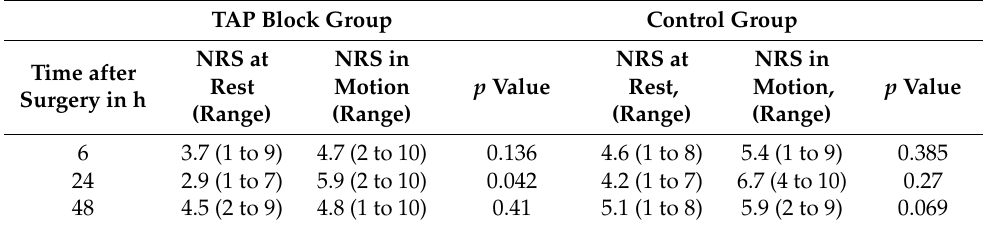
Table 1. Postoperative pain assessment with Numeric Rating Scale (NRS). TAP Block Group Control Group Time